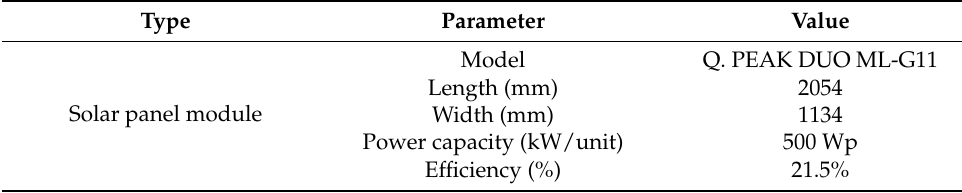
Table 3. Hanwha Q. CELLS’ Q. PEAK DUO ML-G11 solar module. Type